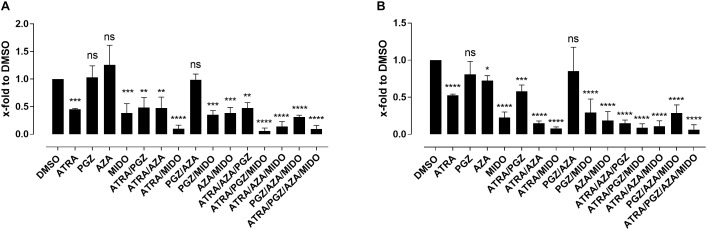
Biomodulatory treatment of AML cell lines in combination with midostaurin. (A) MV4-11 and (B) MOLM-13 cells were incubated in RPMI supplemented with 10% FCS and treated with single agent DMSO, ATRA, AZA, PGZ, MIDO or combinations thereof. On day 3 during treatment cells were counted by trypan blue staining. Data represent means of cell numbers from three independent experiments. Error bars indicate the standard deviation. Statistical analysis for group differences compared to DMSO were performed using Friedman and Dunn’s multiple comparisons test. ns p > 0.05, ∗p ≤ 0.05, ∗∗p ≤ 0.01, ∗∗∗p ≤ 0.001, ∗∗∗∗p ≤ 0.0001.